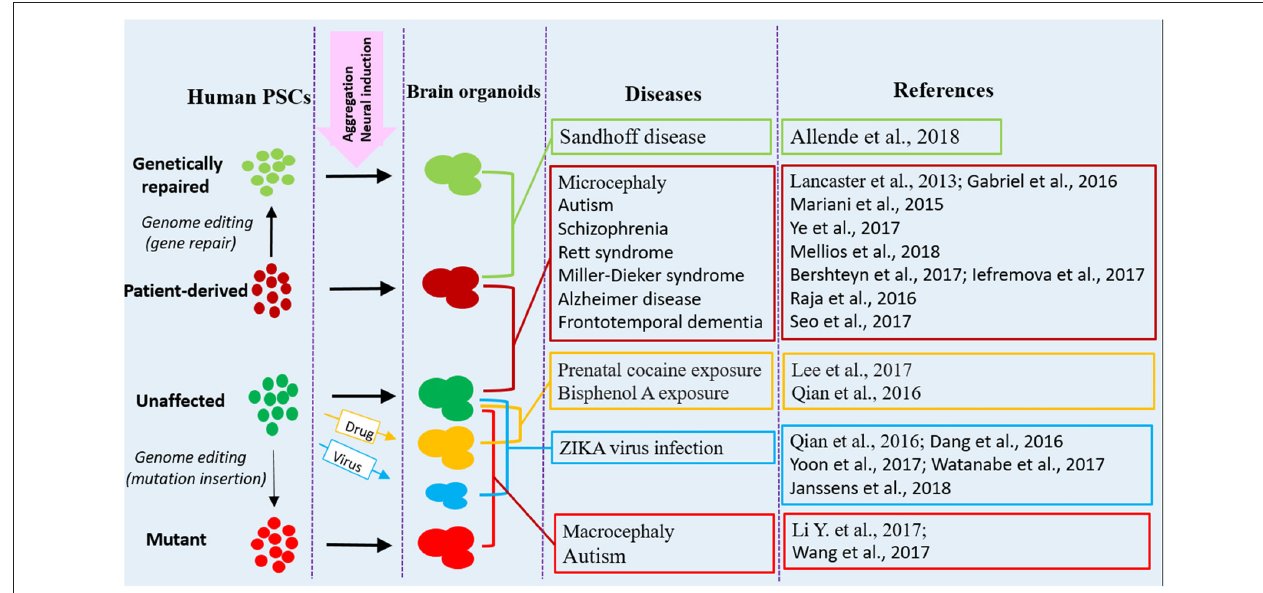
FIGURE 1 | Human brain organoid modeling of neurological diseases. The brain organoid models could be generated using iPSCs derived from patients or by inflicting healthy brain organoids with drugs or virus when the organoids are formed. Alternatively, gene mutations could be introduced into unaffected human PSCs by genome editing (CRISPR-Cas9) to generate brain organoids with relative genetic defects. Patient brain organoids can also be genetically repaired to create isogenic controls. The diseases and references listed here are representative, but unexhausted. Abbreviations: iPSCs, induced pluripotent stem cells; PSCs, pluripotent stem